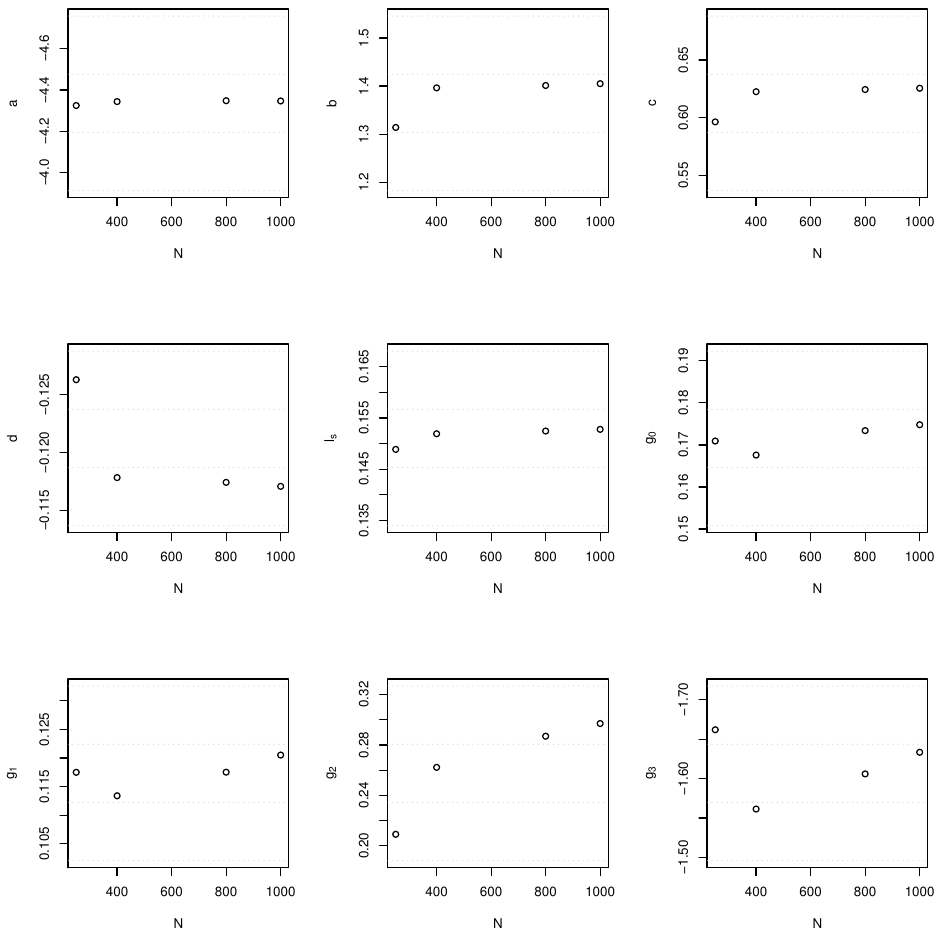
Figure 9 . Evolution of best (cid:12)t parameters with the number of interpolation points N